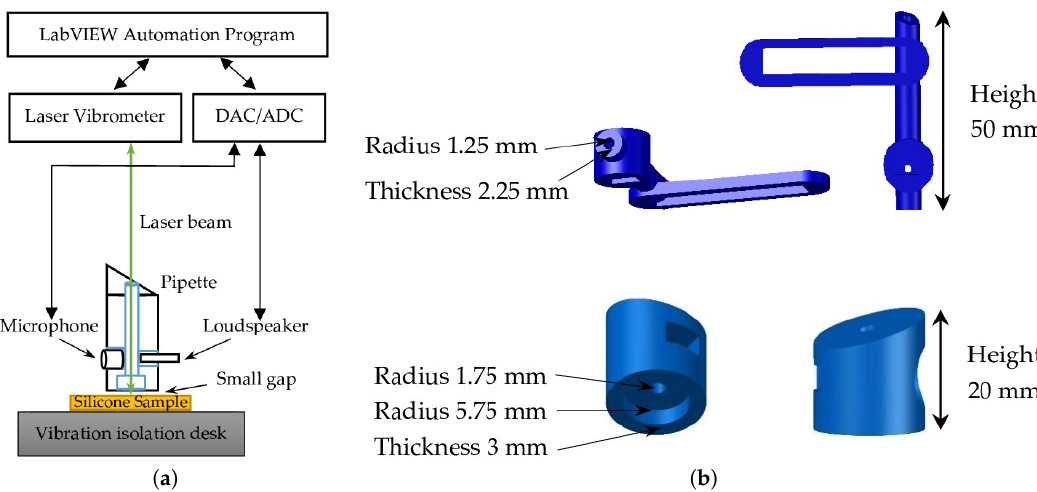
Figure 3. ( a ) schematic picture of the measurement setup; ( b ) drawing of the miniaturized